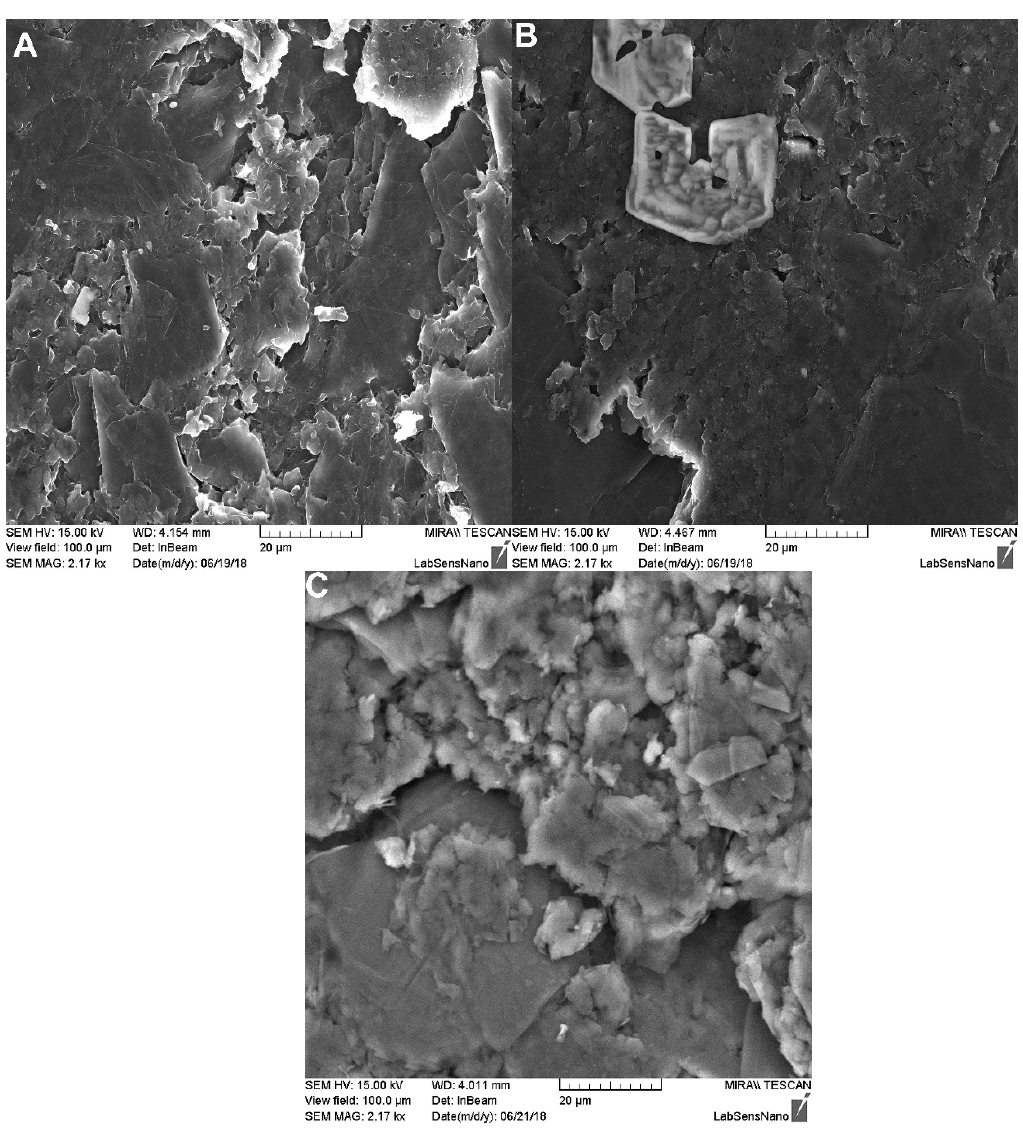
Figure 2. The SEM images of the prepared MWCNT-CPEs: ( A ) 15% MWCNT-CPE; ( B ) 25% MWCNT- Figure 2. TheSEMimagesofthepreparedMWCNT-CPEs: ( A )15%MWCNT-CPE;( B )25%MWCNT-CPE; CPE; ( C ) 35% MWCNT-CPE. ( C ) 35%